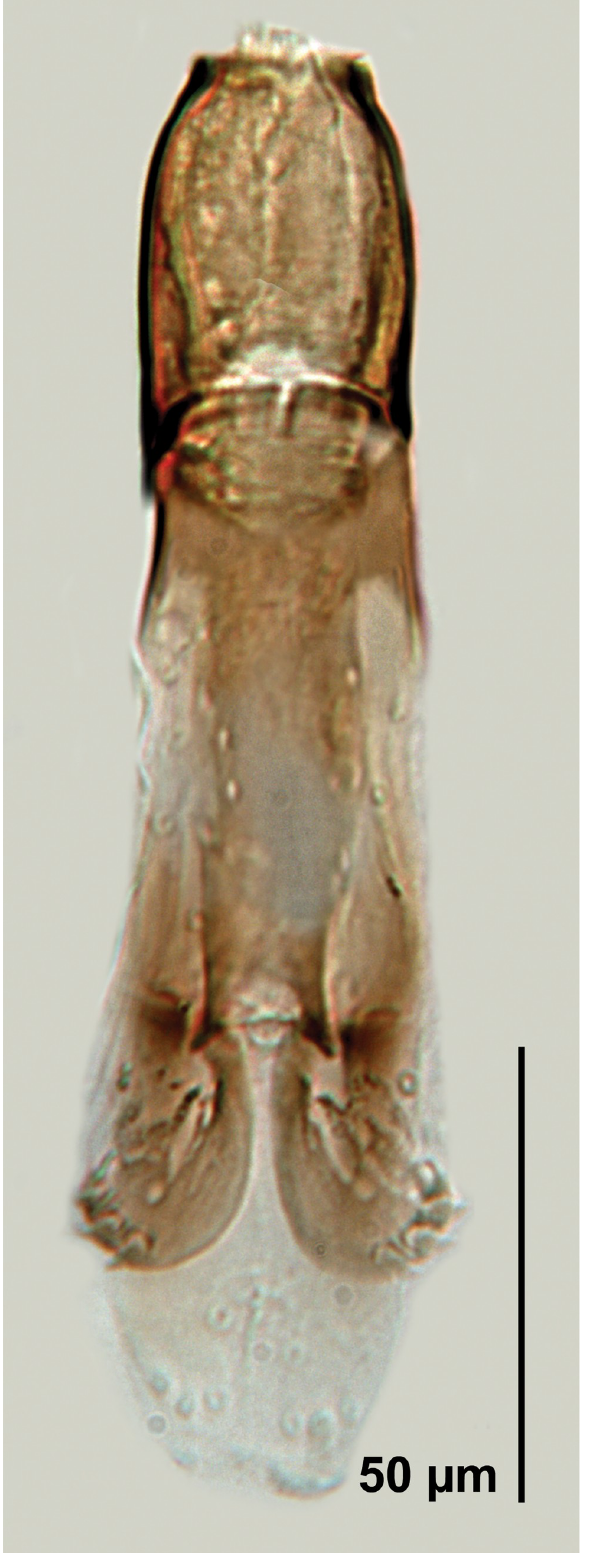
Fig 8. Telenomus nizwaensis Polaszek male genitalia.